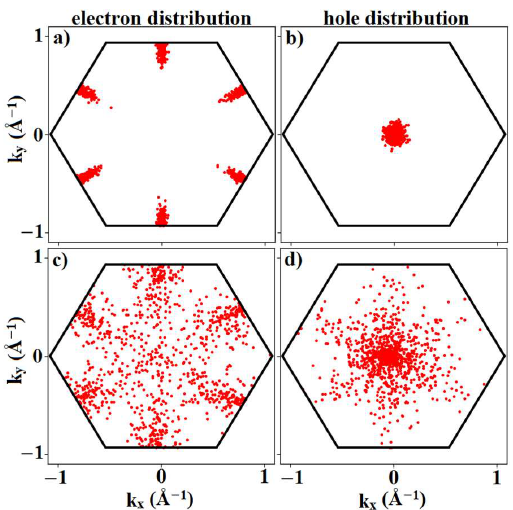
Figure 9. Distribution of ( a , c ) electrons and ( b , d ) holes in ( a , b ) low electric fields (E field = 10 3 V/cm) and ( c , d ) high electric fields (E field = 5 × 10 5 V/cm) in the FBZ of silicane at room temperature (T = 300 K). It can be seen at low electric fields that electrons (holes) were confined at the M (Γ) valley. Increasing electric fields resulted in the scattering of electrons from the M to the Γ valley and also resulted in the occupation of higher energy states. For holes, increasing the electric fields would increase occupation towards the M point.